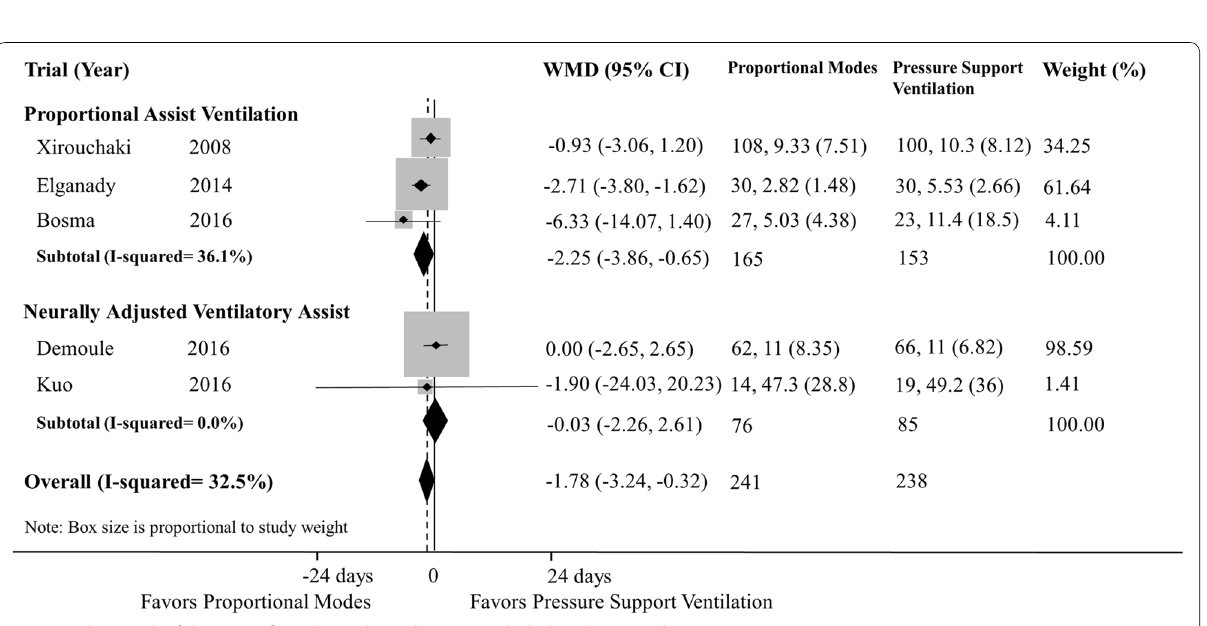
Fig. 4 Relative risk of duration of mechanical ventilation in included studies. RR risk